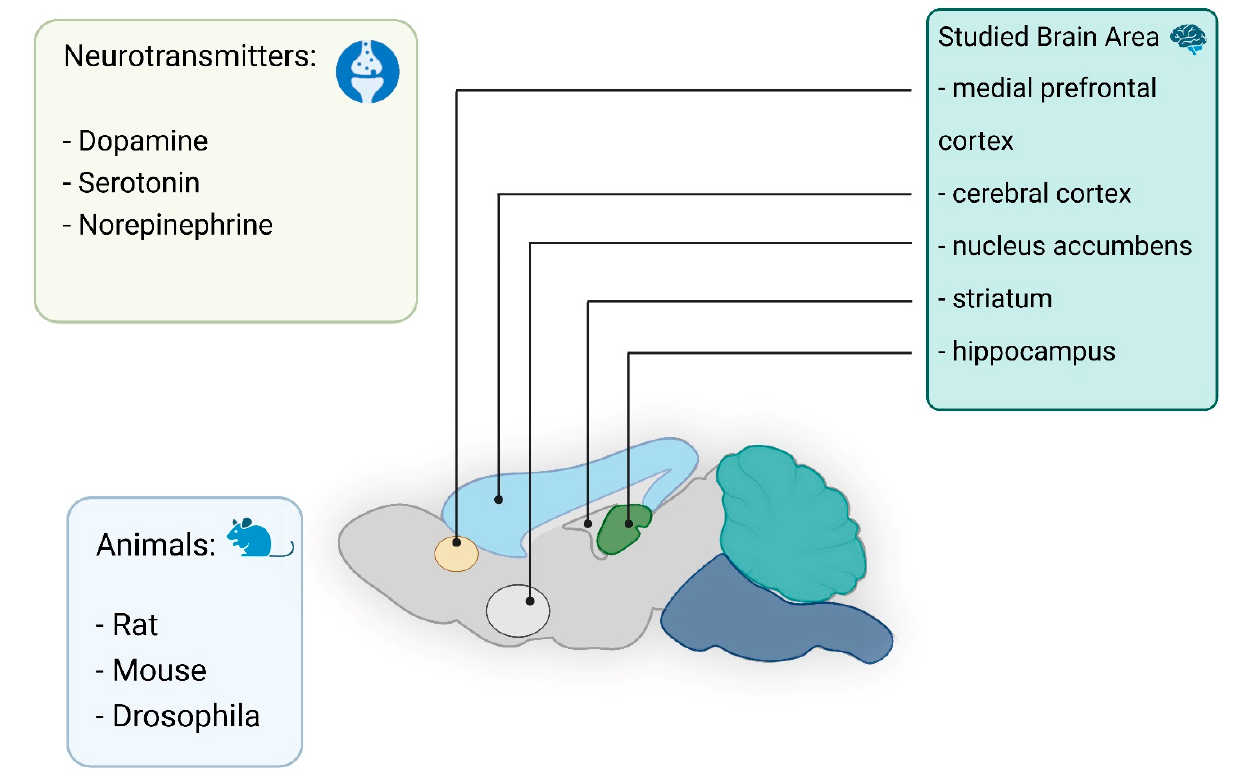
Figure 2. Summary of in vivo detection neurotransmitters in different area of the brain.